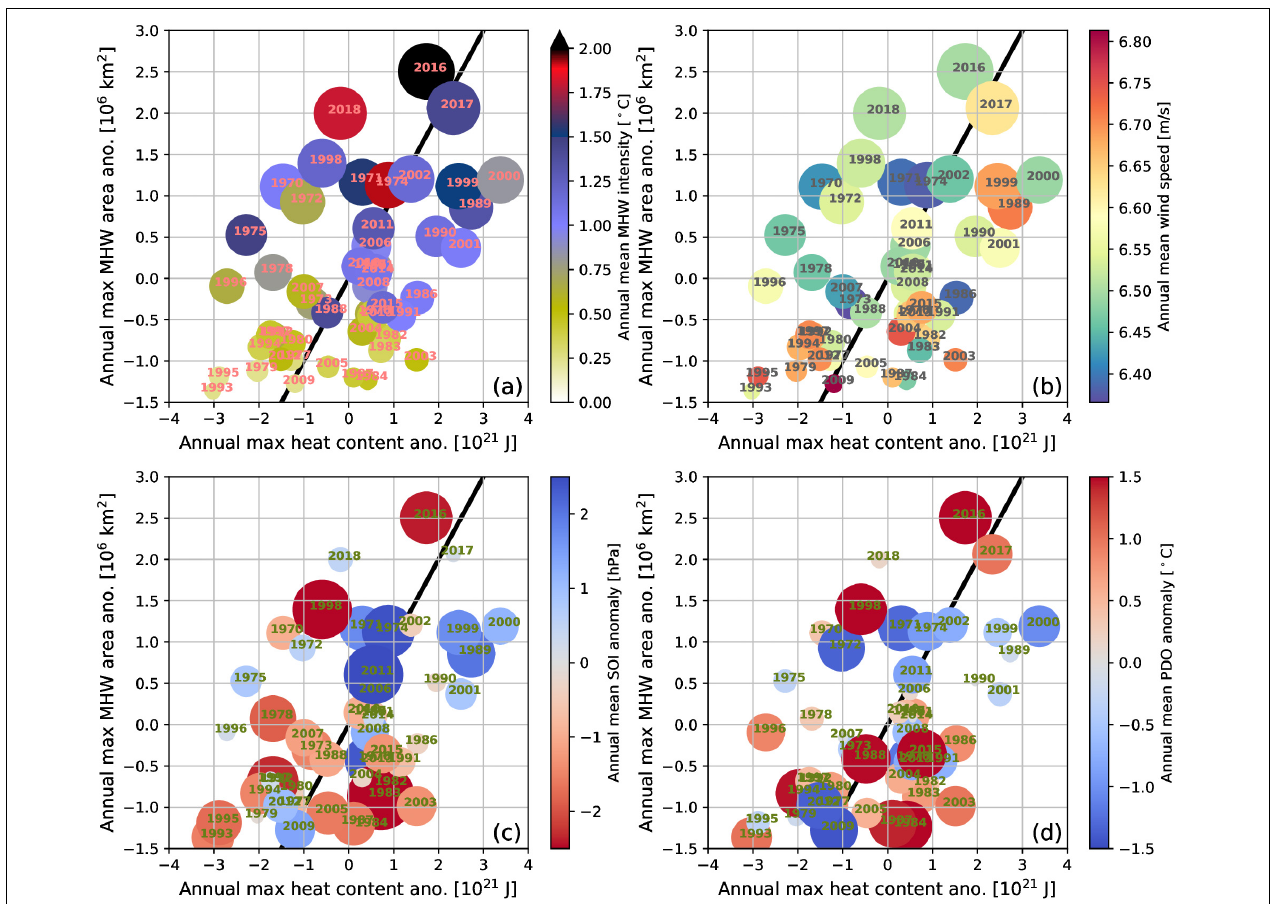
FIGURE 11 | Link between upper ocean heat content and area of MHWs on annual basis. Scatter plot shows annual maximum of heat content (x-axis) and annual maximum MHW area (y-axis), over the Tasman Box (a–d) . Annual averages are centered on Southern Hemisphere summers, for example maximum/mean values for 2000 cover the period from June 1999 through to May 2000. (a,b) size of the circles is proportional to the annual maximum MHW area (y-axis), while color indicates (a) annual mean MHW intensity and (b) annual mean wind speed. (c,d) as for (a,b) but size and color of circles show annual mean SOI anomaly (c) and PDO anomaly (d)